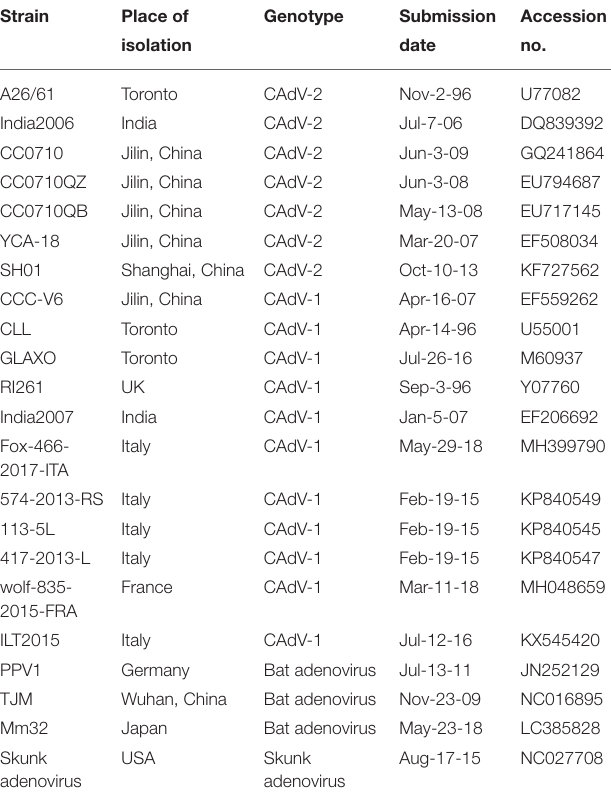
TABLE 2 | Reference strains used in the